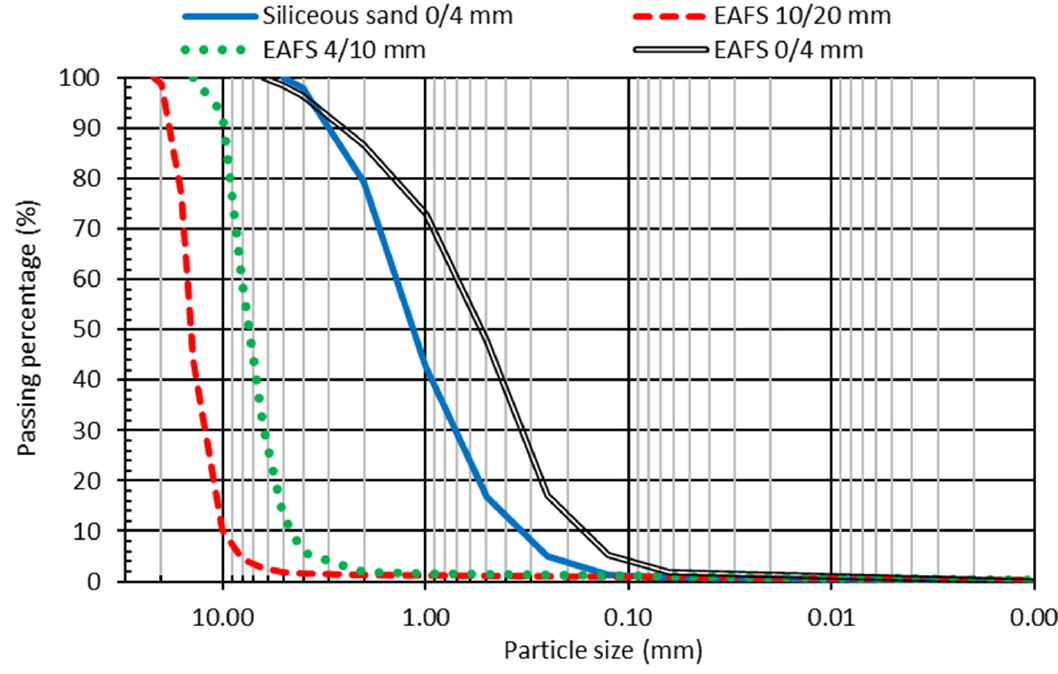
Figure 1. Gradation of